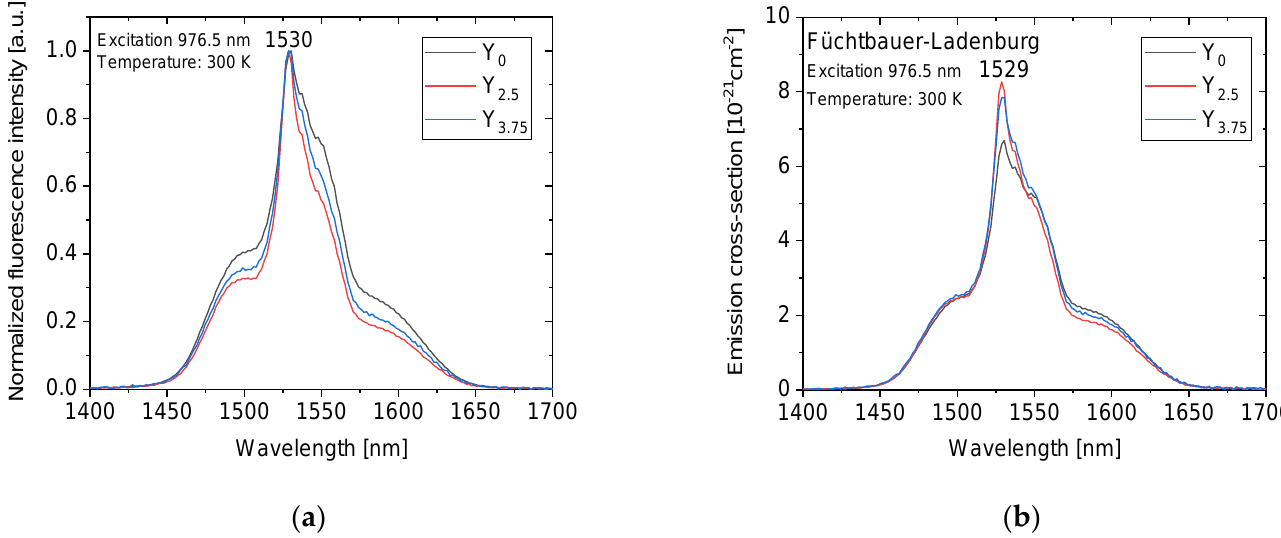
Figure 9. The emission spectra ( a ) and calculated emission cross-section ( b ) of the glasses. The emission cross-sections were calculated using Equation (2) and are shown in Figure 9b. The emission cross-sections of the newly developed glasses are comparable to those of other Er 3+ -doped phosphate glasses, including commercial ones [13,18,24].